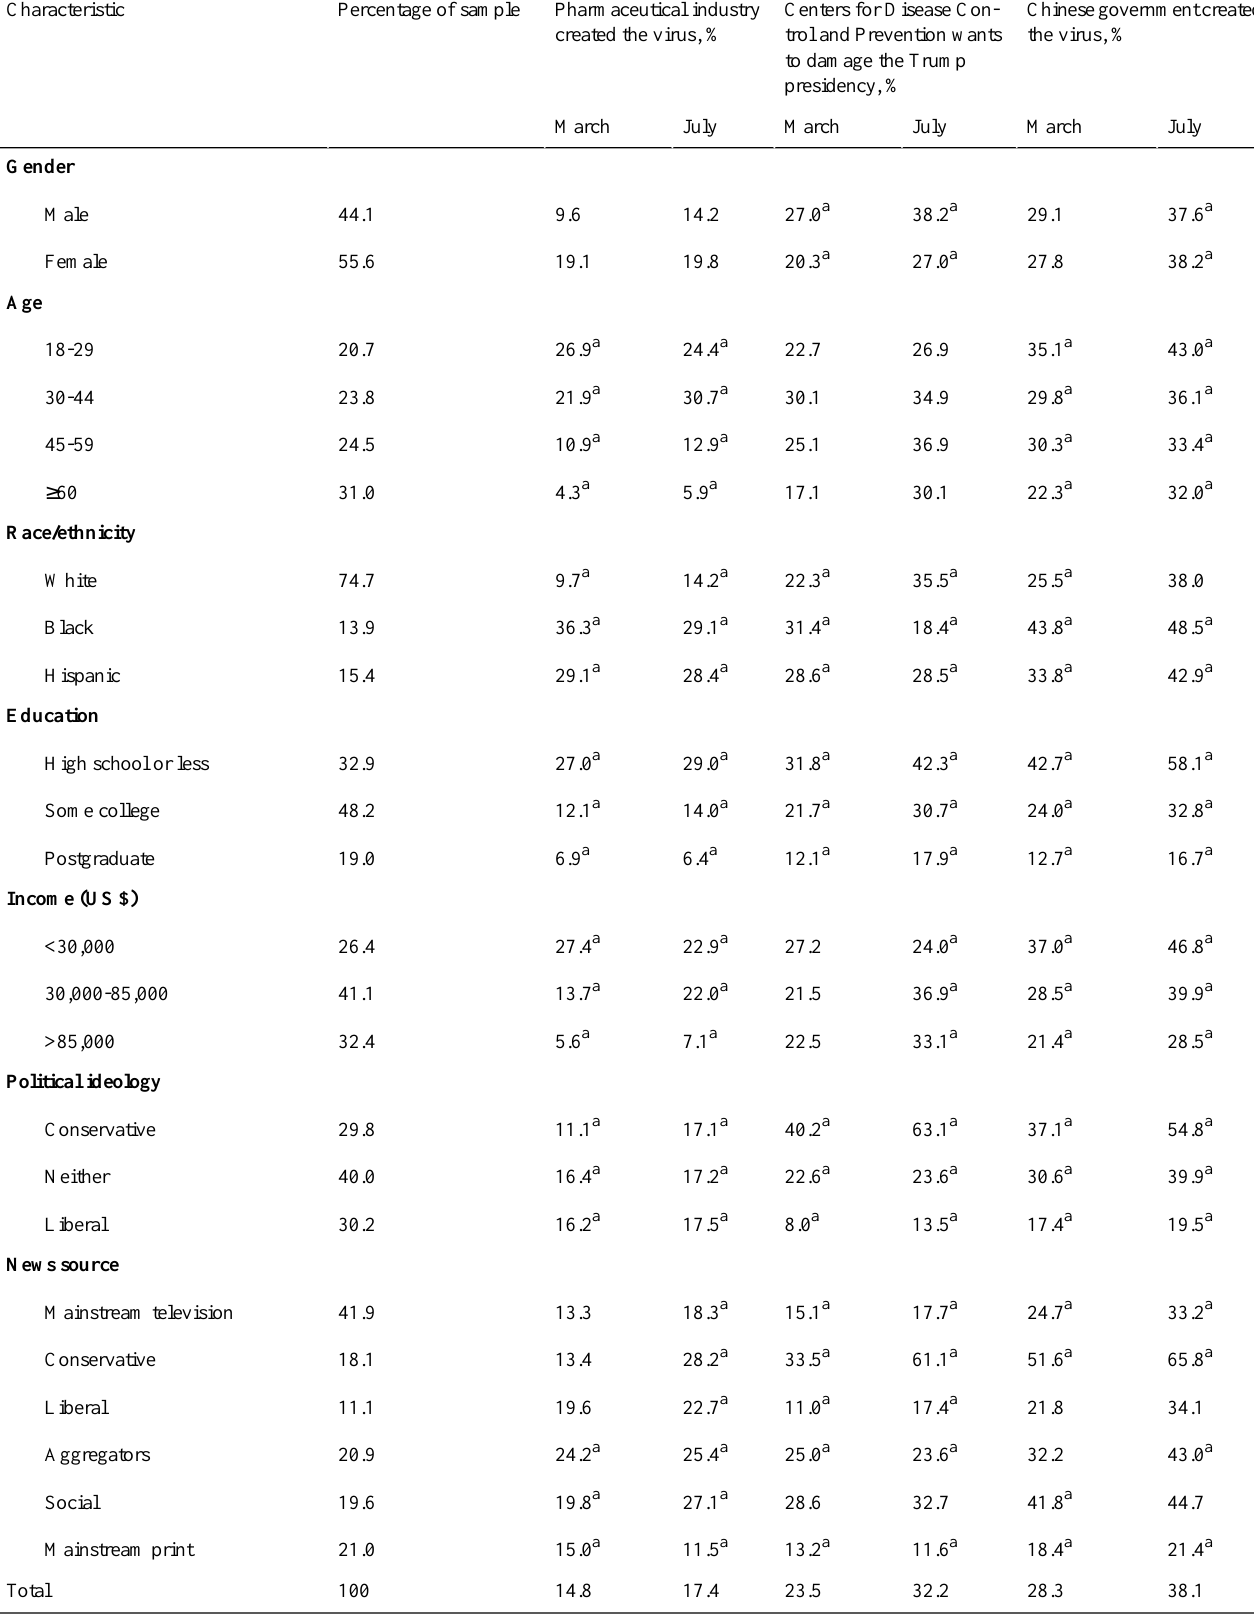
Table 2. Percentages of sample believing that each conspiracy belief was either “definitely true” or “probably true” by demographic characteristics and news use in March and July 2020 (N=840,